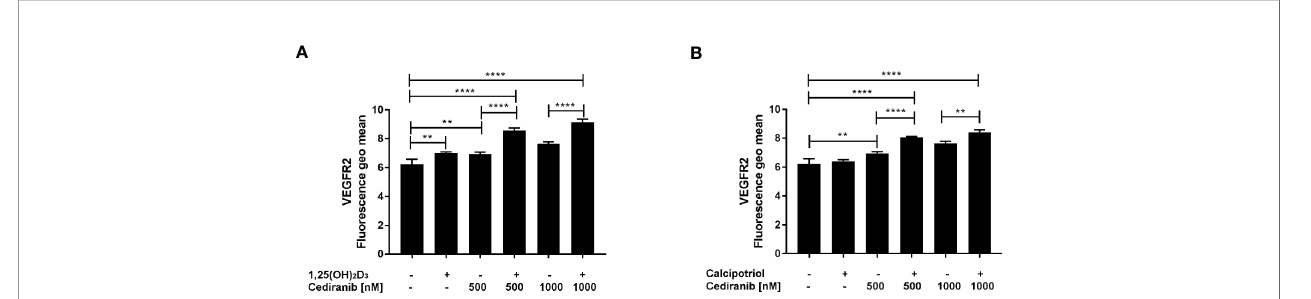
FIGURE 4 | The effect of 24-h preincubation with 1,25(OH)2D3 (A) or calcipotriol (B) at 100 nM concentration on the extracellular expression of the VEGFR2 in A375 melanoma cells treated subsequently for 24 h with cediranib at 500 or 1,000 nM concentration. Cells were stained with appropriate antibody (see Materials and Methods section) and analyzed cytometrically. The data are presented as the mean ± standard deviation ( n = 3). The same control and cediranib data are plotted in each graph. Statistical signi fi cance was estimated using one – way ANOVA followed by Tukey ’ s multiple comparison test and presented as ** p < 0.01 or **** p < 0.0001. The results are representative of three experiments.